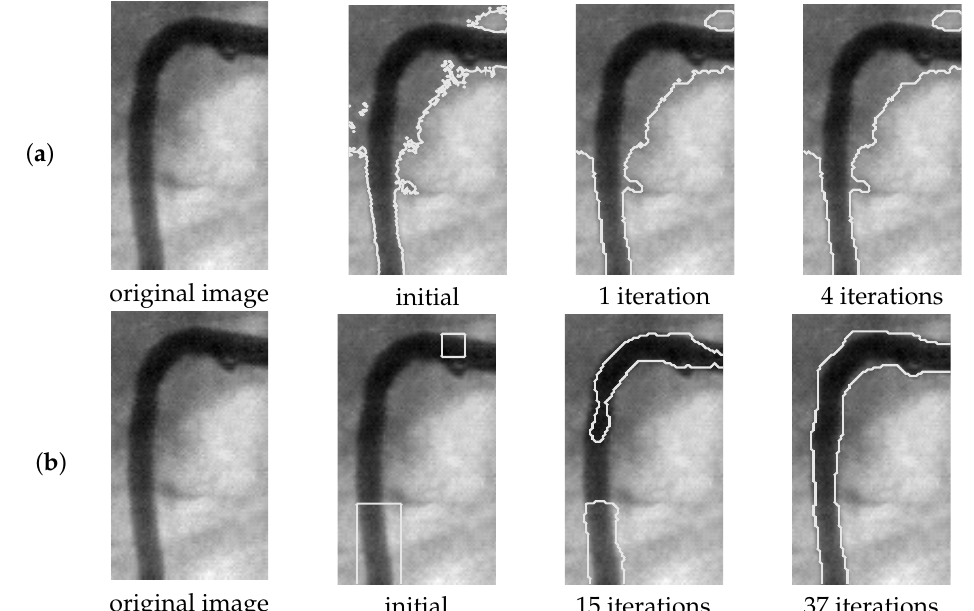
Figure 14. Coronary image having intensity inhomogeneity. Original image from [25] which permissions by Elsevier and temporal segmented results. Here, the initial conditions are used by ( a ) φ 0 = 2 f 0 − 1 and ( b ) two designated rectangles.